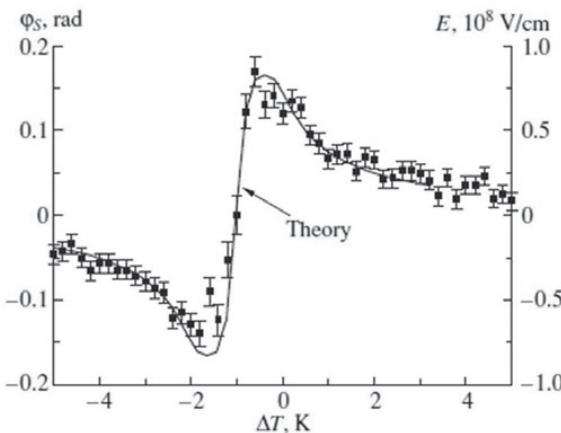
Figure 2. Spin-rotation angle as a function of the temperature difference between the analyzer crystal and the working crystal [37,38].